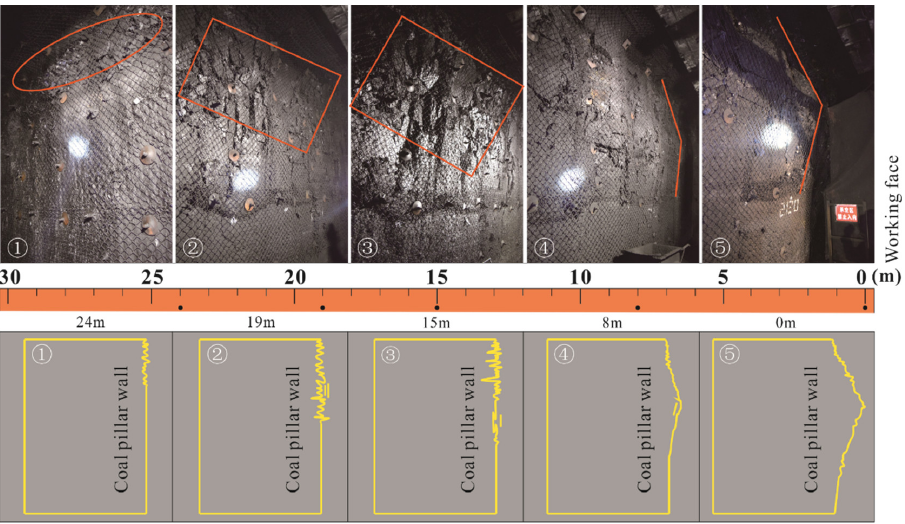
Figure 2. Failure diagram and sketch of the coal pillar wall in the supporting pressure area.